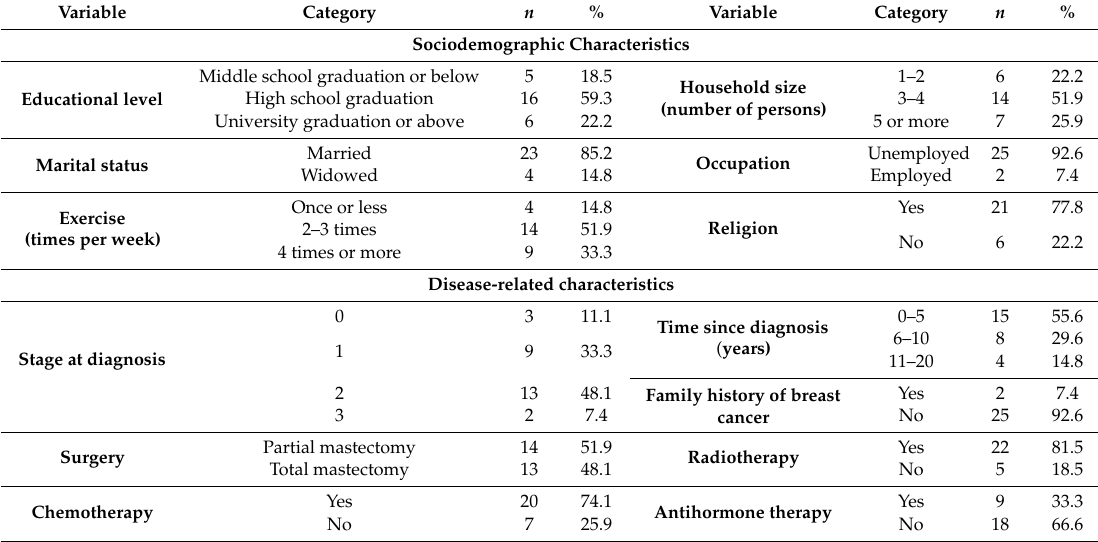
Table 2. General participant characteristics (N =